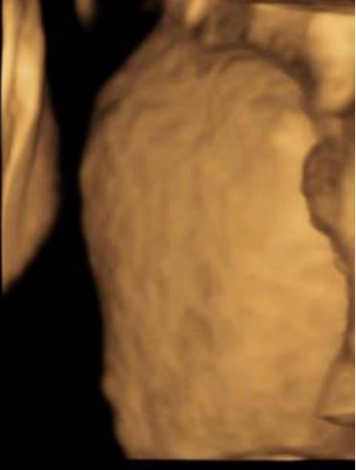
Figure 6. 3D ultrasound image of the lumbosacral region.